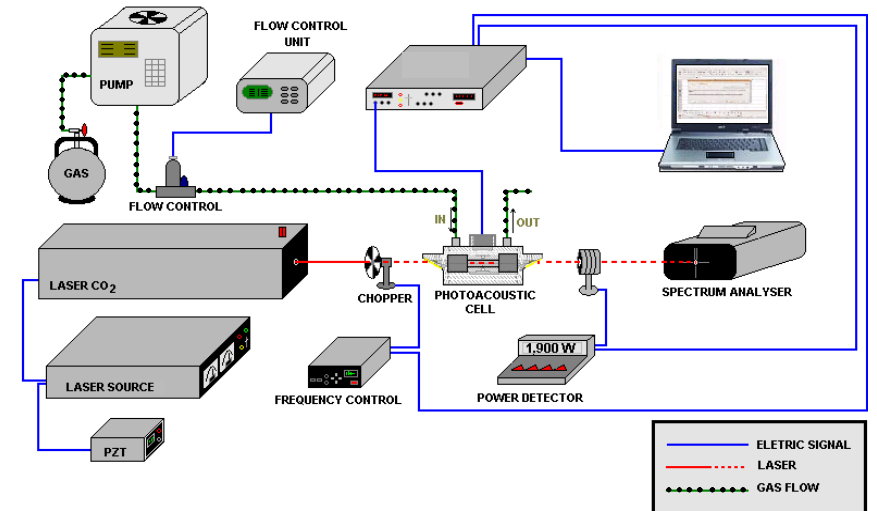
Figure 1. Scheme of the photoacoustic experimental